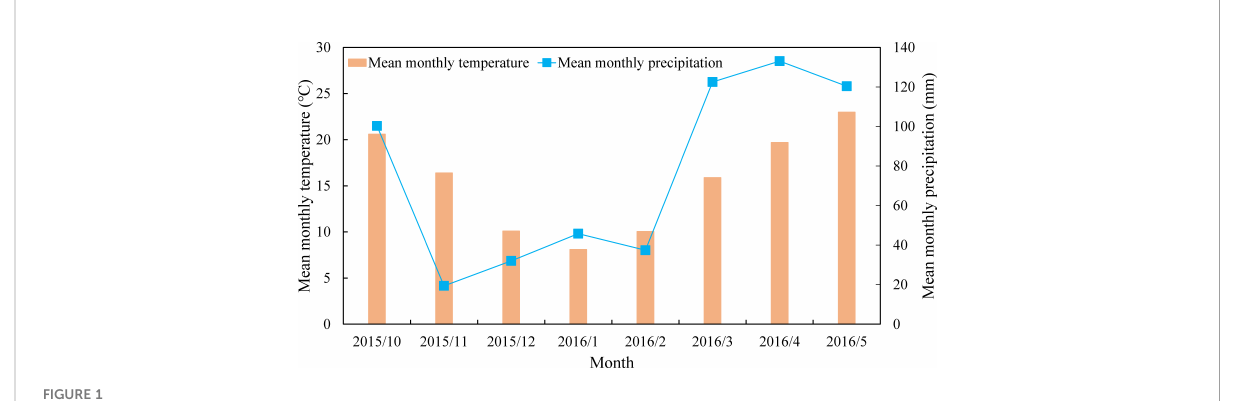
FIGURE 1 Mean monthly temperature and precipitation during the